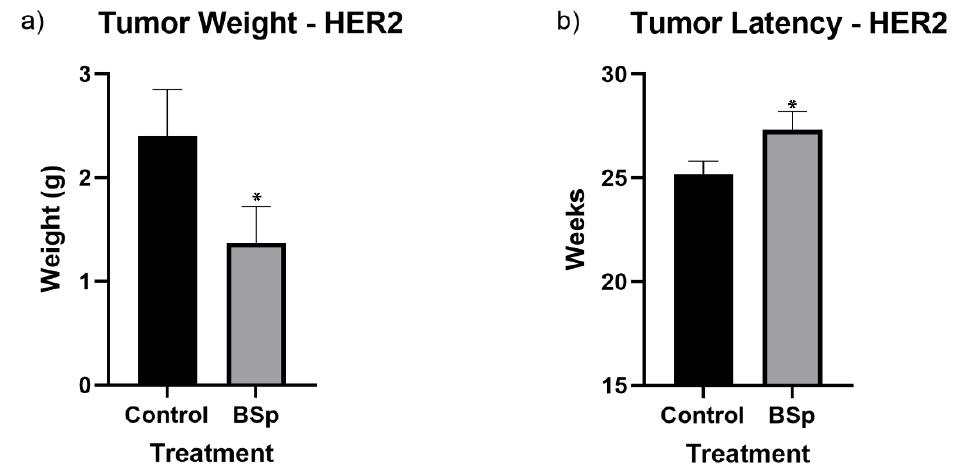
Figure 3. Tumor weight ( a ) and latency ( b ) of HER2/neu mice. BSp treatment significantly decreased mean tumor weight by 0.9 g and significantly increased mean tumor latency. For each group n = 24 mice. * = p < 0.05.